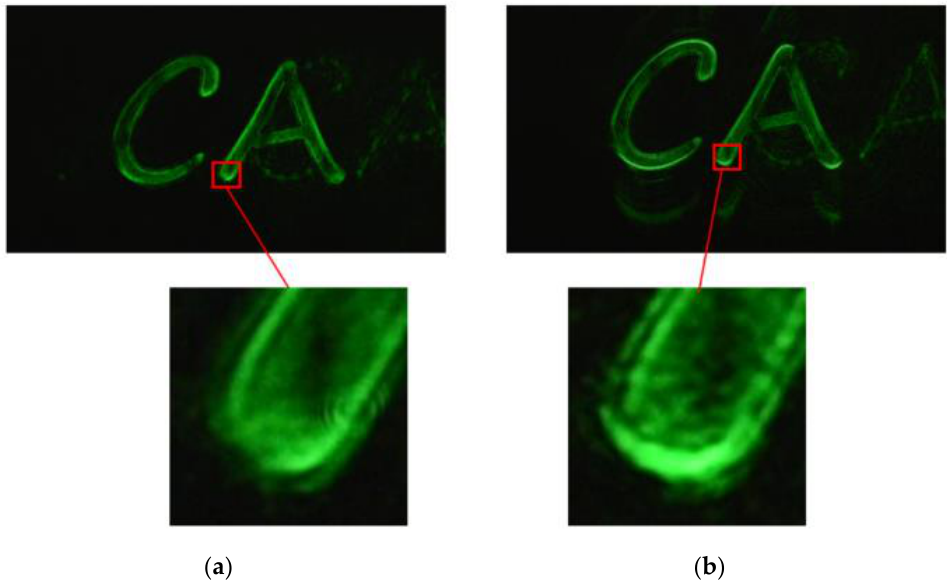
Figure 4. Results of the reconstructed image of “ CA ” without loading DOEs. ( a ) Result by using the traditional NLUT algorithm; ( b ) result by using the algorithm based on effective perspective calculation.